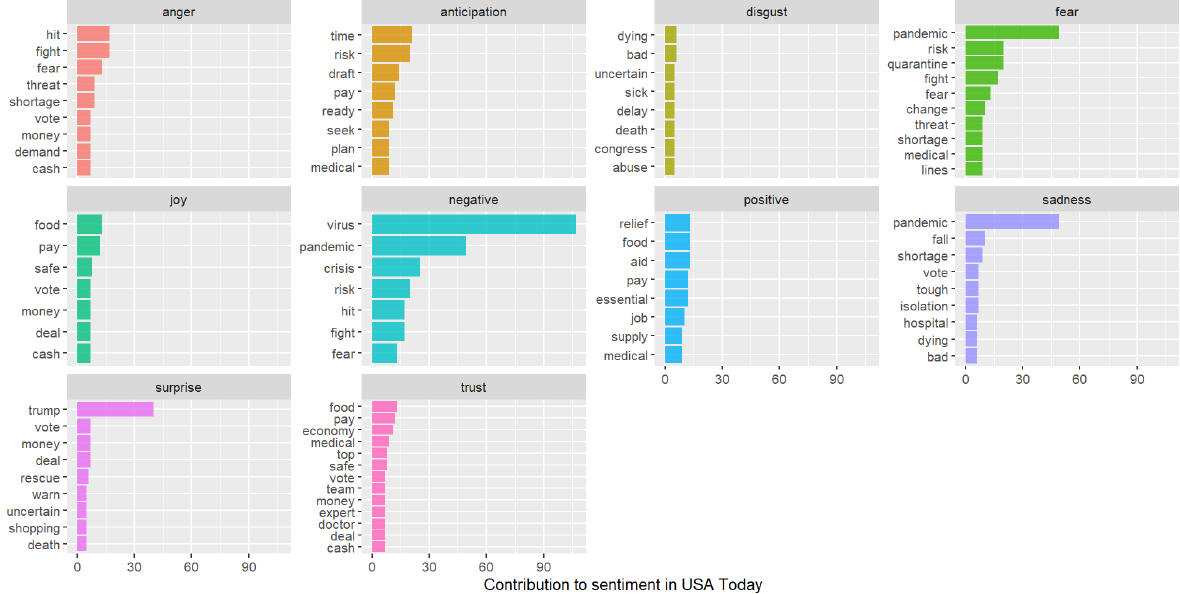
Figure 12. Top word distributions for each emotional valence (USA Today).